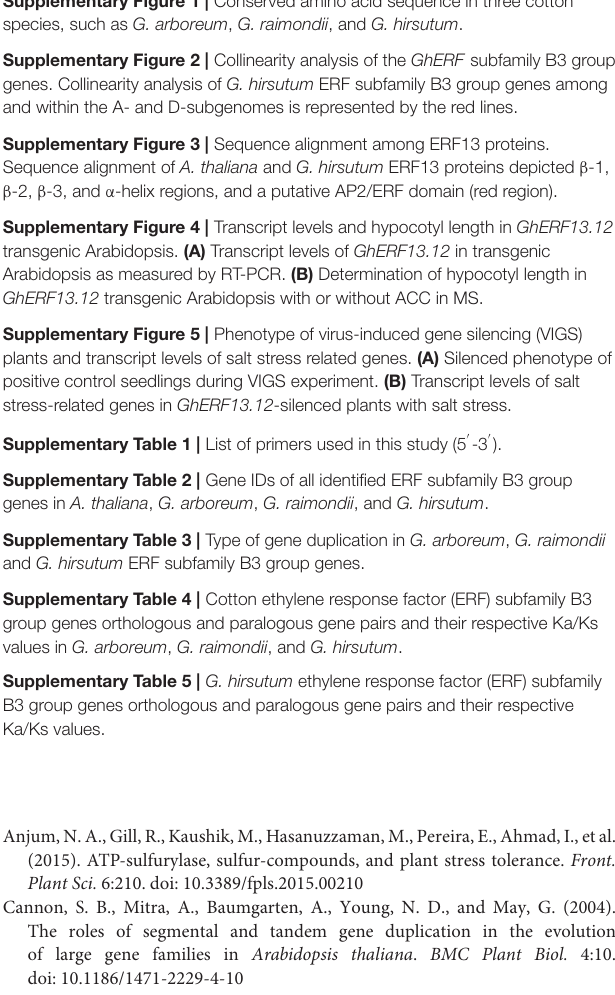
Supplementary Table 3 | Type of gene duplication in G. arboreum , G. raimondii and G. hirsutum ERF subfamily B3 group genes. Supplementary Table 4 | Cotton ethylene response factor (ERF) subfamily B3 group genes orthologous and paralogous gene pairs and their respective Ka/Ks values in G. arboreum , G. raimondii , and G. hirsutum